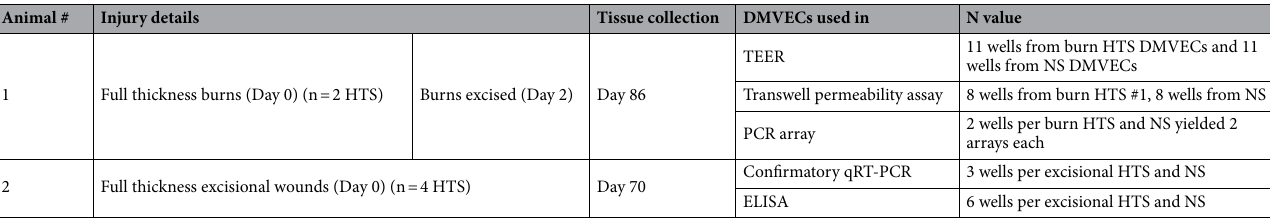
Table 1. Animal injury and experimental usage